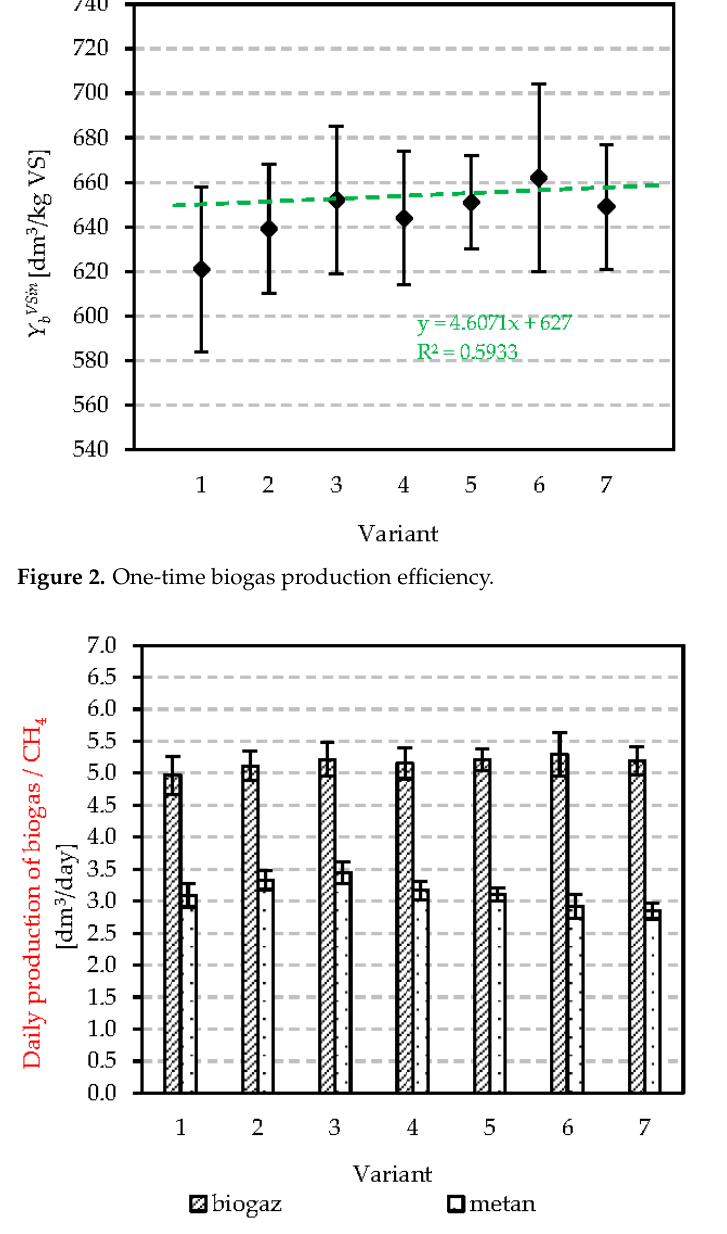
Figure 3. Daily biogas and CH 4 yield.